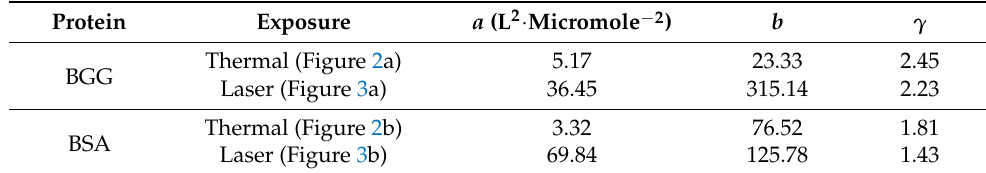
Table 1. Parameters of the model function (24). Protein